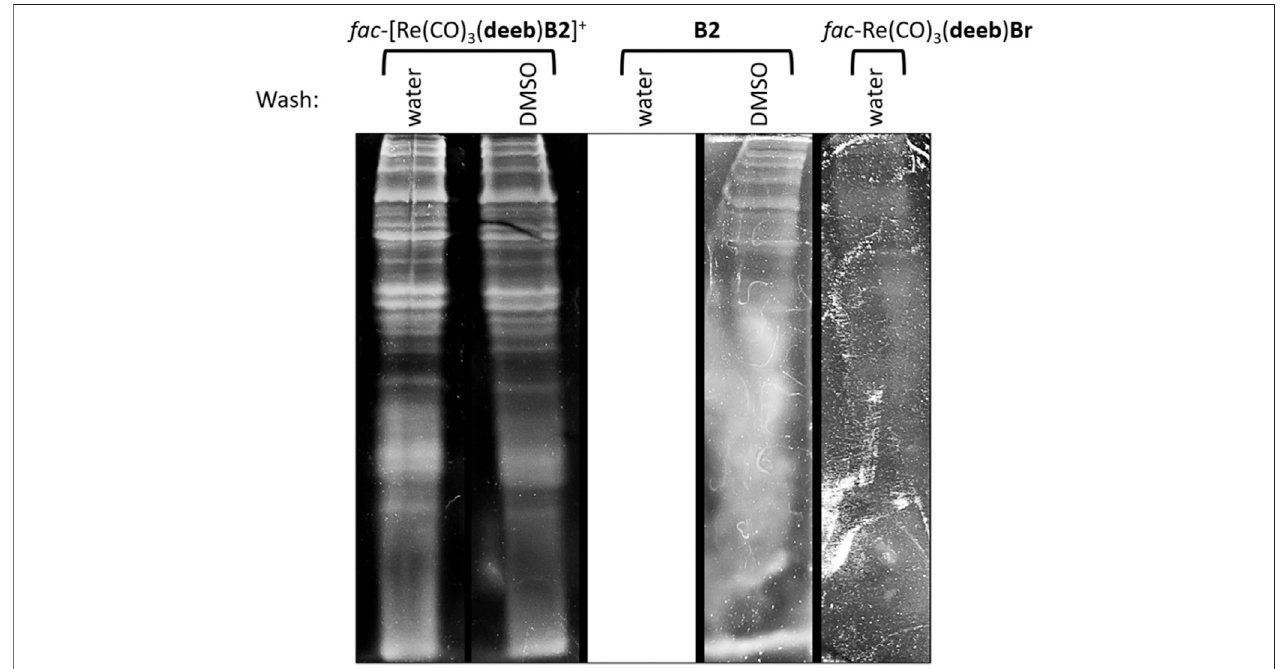
FIGURE4| TotalproteinswereextractedandresolvedinSDS-PAGEbeforebeingstainedwith fac -[Re(CO) 3 ( deeb ) B2 ] + , B2 ,or fac -Re(CO) 3 ( deeb )Brfor60 minat room temperature. Gels were then washed with either distilled water (10 min) or DMSO 25% (12 h). Stained proteins were observed in a UV transilluminator ECX-20M ( λ (cid:2) 312